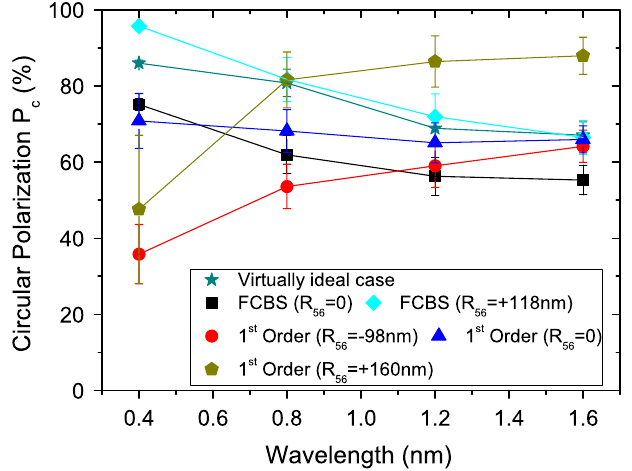
FIG. 16. (Color) Degree of circular polarization of a crossed planar undulator system using two 3 m long planar segments with a 90 (cid:1) phase lag installed after the different kinds of bending systems discussed in this paper. The error bars are given by the limited simulation accuracy.